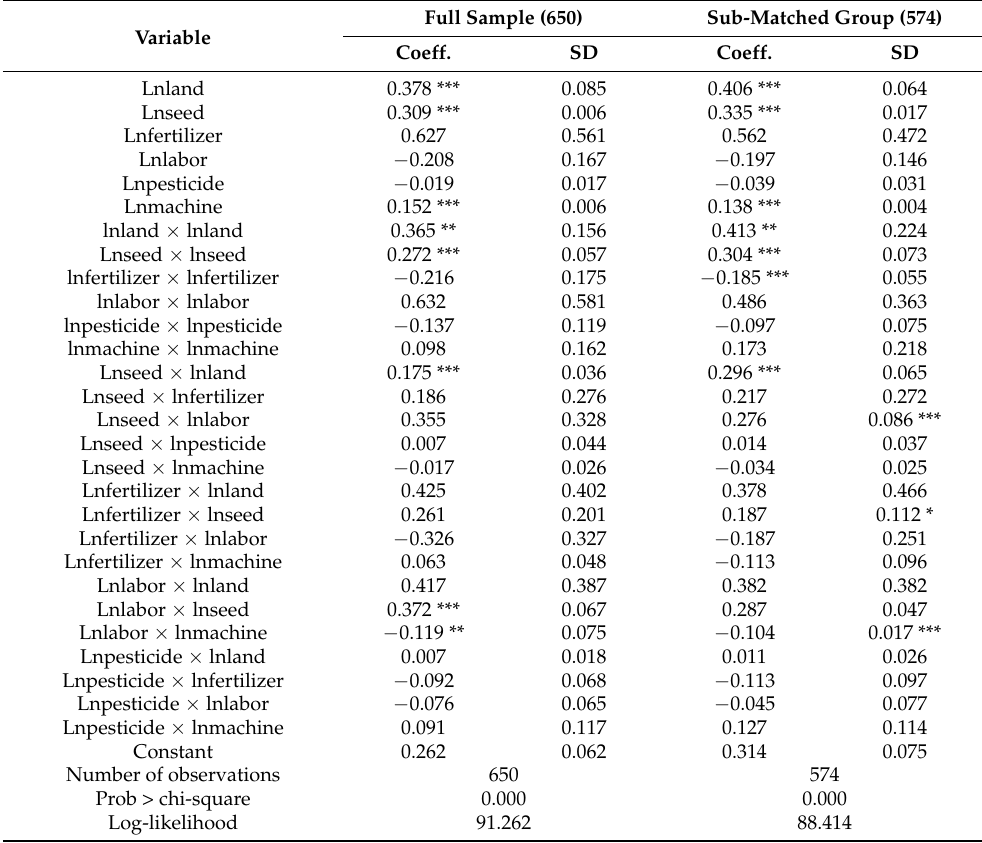
Table 3. Stochastic translog estimation for organic rice production in Punjab,